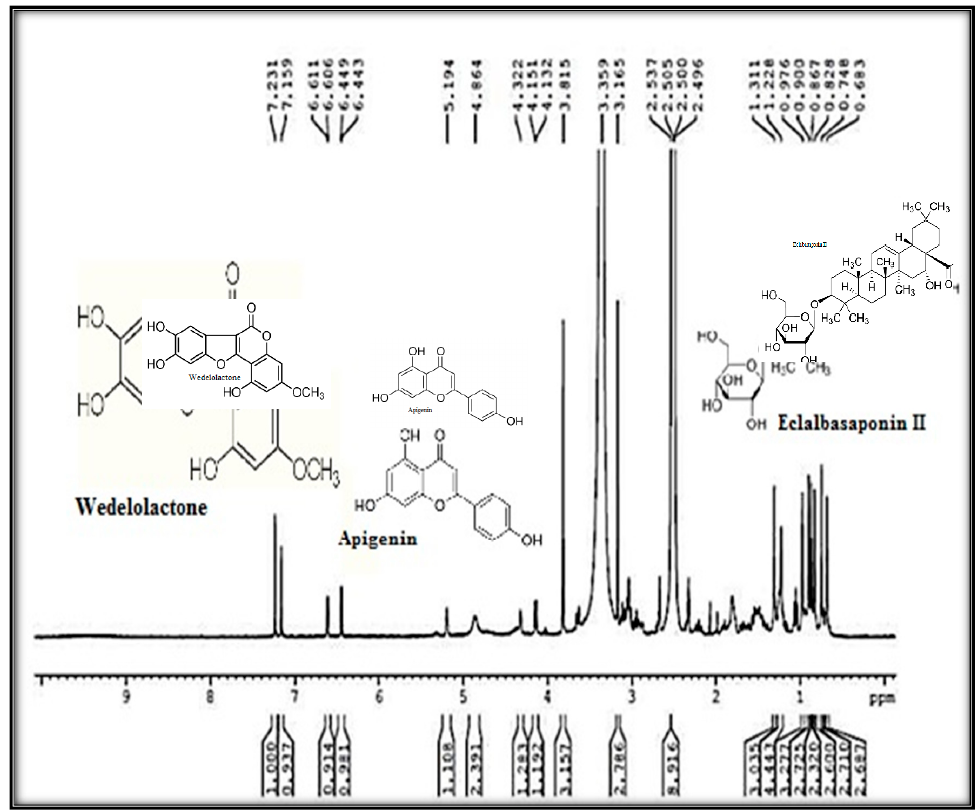
Figure 5. UPLC chromatogram profile of the column purified fraction of E. alba at 260 nm.